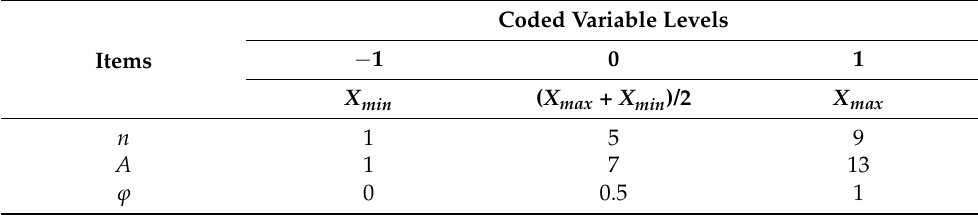
Table 2. Design parameters and coded in BBD.